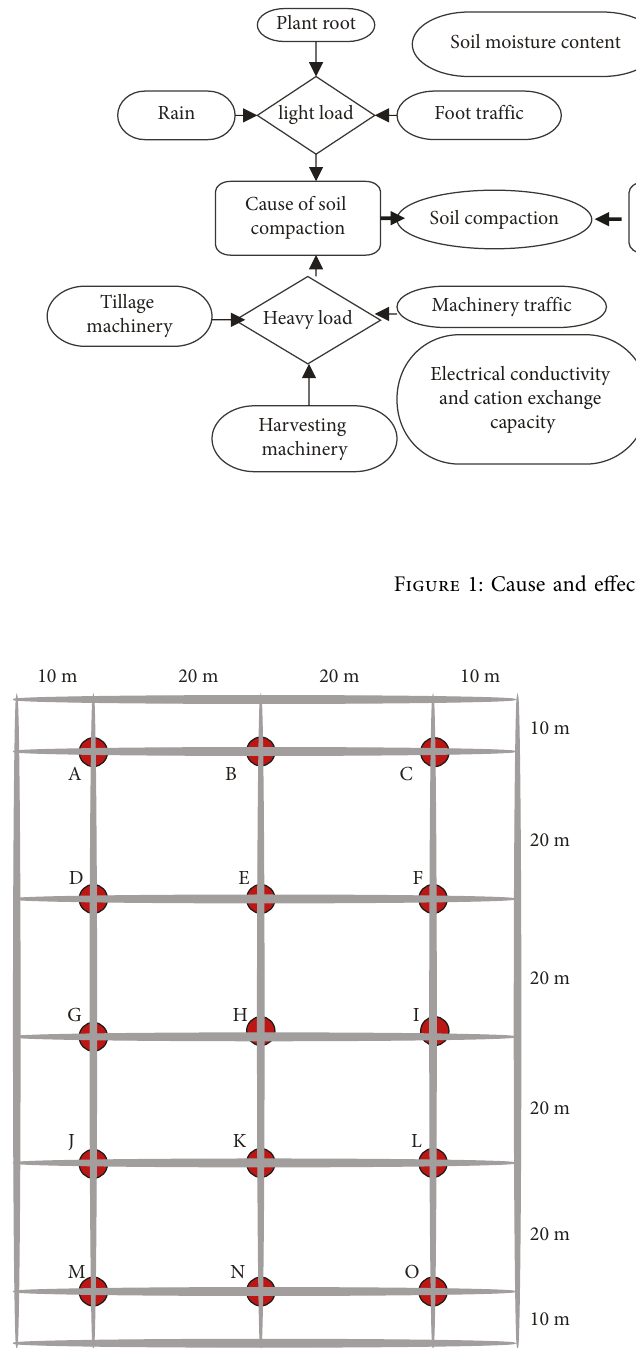
Figure 2: Data sampling, plot design, and distribution of